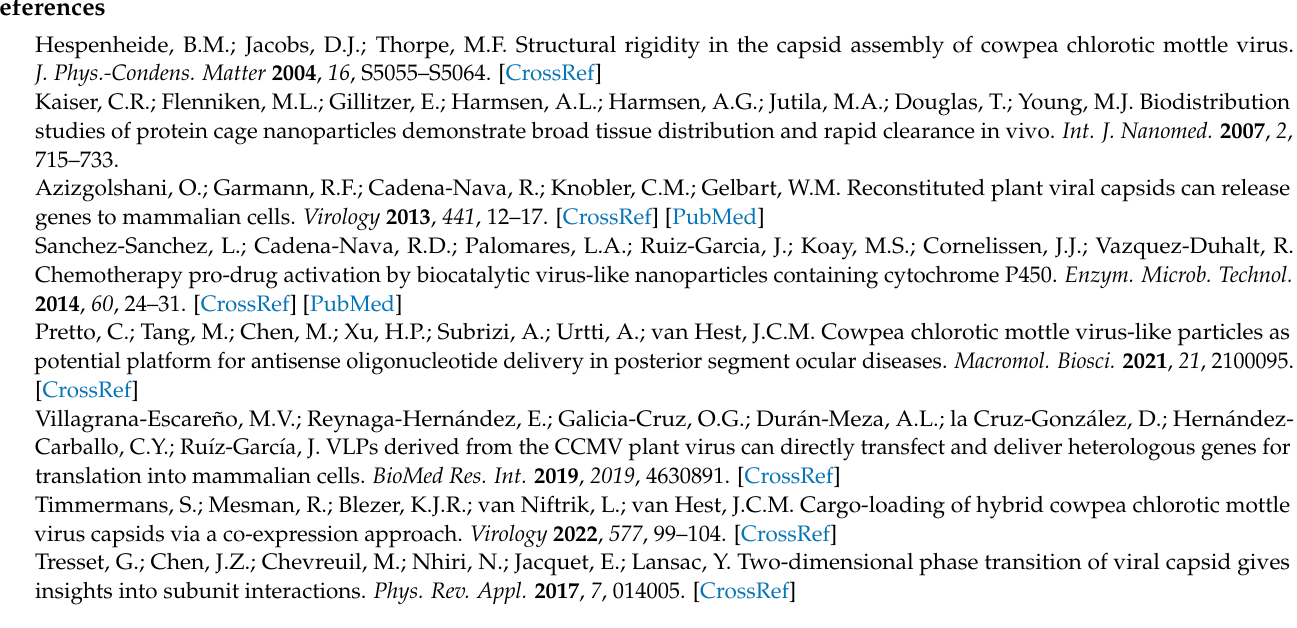
spectrum of CCMV; Figure S7: Dynamic light scattering of CCMV; Figure S8: Titer determination of rabbit antiserum against CCM; Figure S9: Peptide Mass Fingerprint of BAM-CCMV-28-81 for identity confirmation; Figure S10: Calculation of LOD and LOQ for CCMV immunoassay. Reference [64] is cited in Supplementary